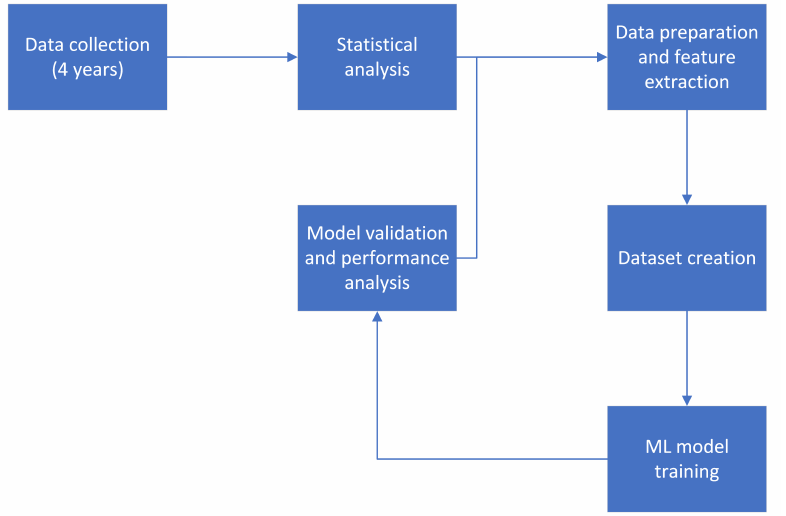
Figure 6. Research methodology